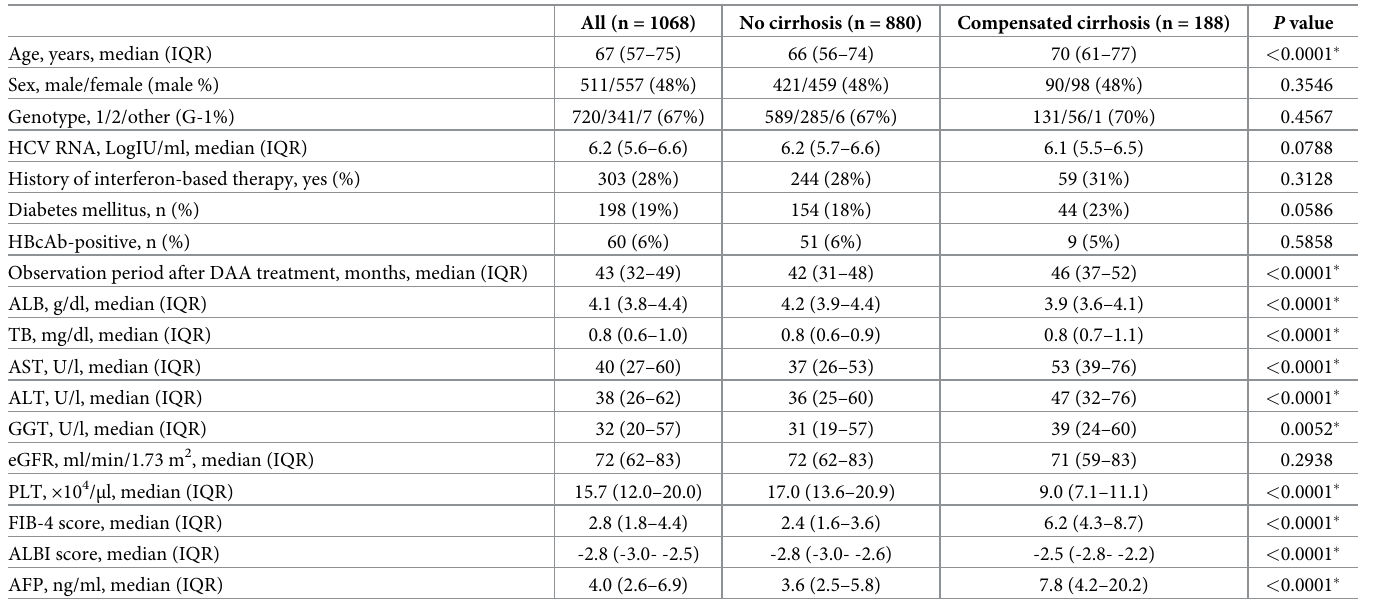
Table 1. Characteristics of 1068 patients with hepatitis C virus.